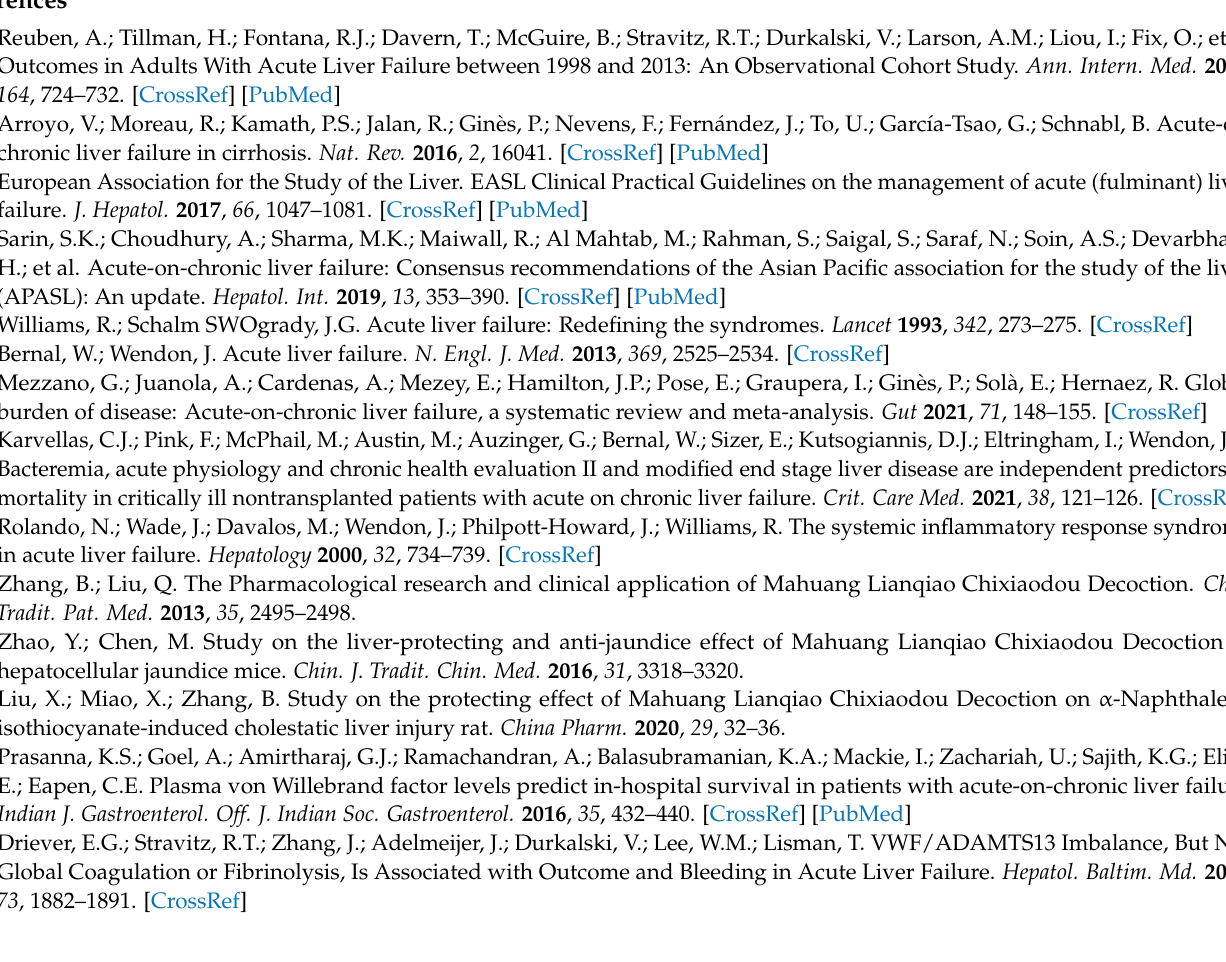
Figure S3: The network targets from top 10% DEPs between ALF/ACLF+MHLQD and ALF/ACLF group. Table S1: The chemical compositions of MHLQD identified by